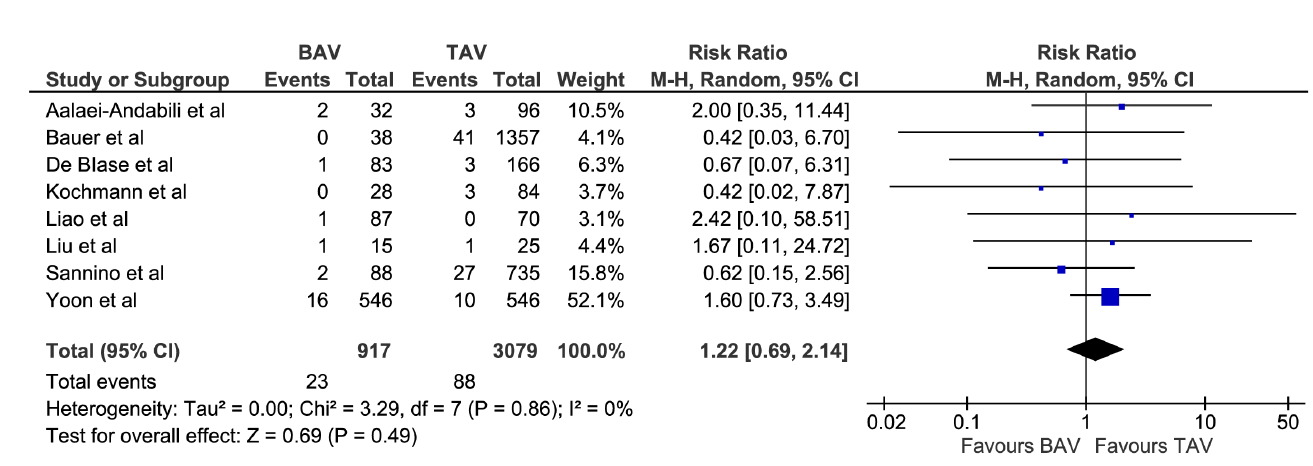
Fig. 2 - Forest plot for postoperative stroke. BAV=bicuspid aortic valve; CI=confidence interval; M-H=Mantel-Haenszel; TAV=tricuspid aortic